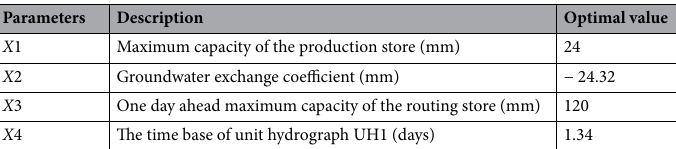
Table 3. Parameters setting by pattern search approach for GR4J model.